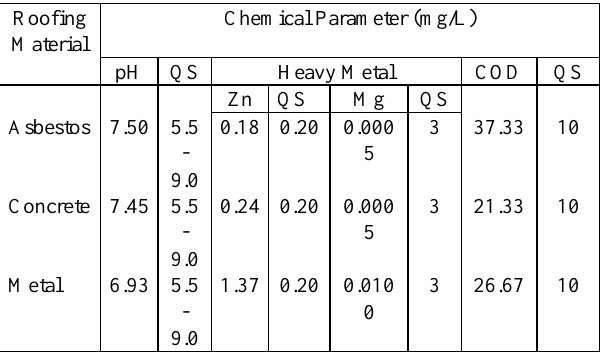
Table 1: Results of Chemical Parameters